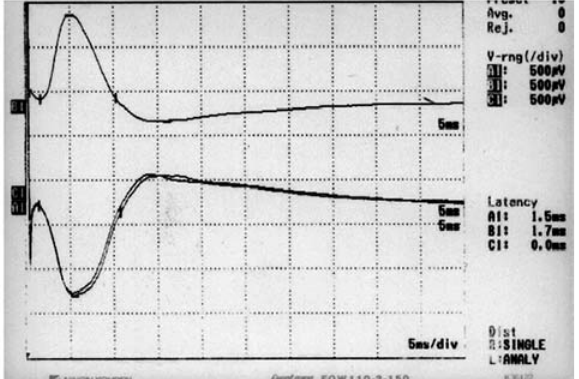
Figure 2 – Registrations of the M-wave. Superior and inferior traces were obtained, respectively on the right and left. They present inverted signals due to the opposed functions performed by the bipolar registration electrodes (active and reference) when we utilize each hand on its corresponding